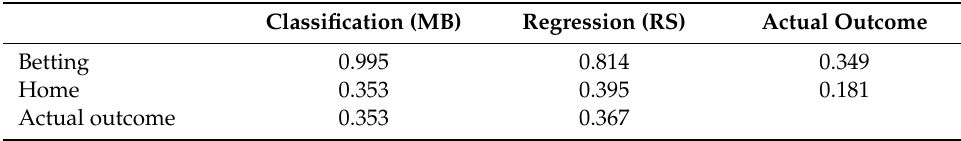
Table 5. Kappa coe ffi cient for the pairwise comparison of the predictive outcome. Table 5. Kappa coefficient for the pairwise comparison of the predictive outcome.